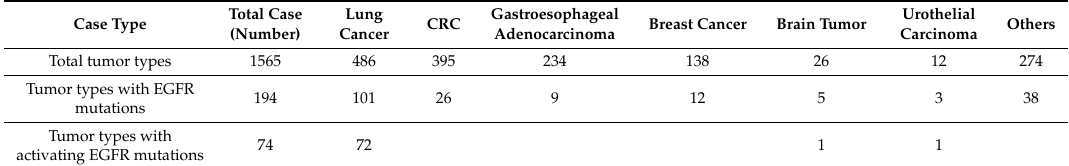
Table 1. Tumor Types and Distribution of Epidermal Growth Factor Receptor (EGFR) Mutations.